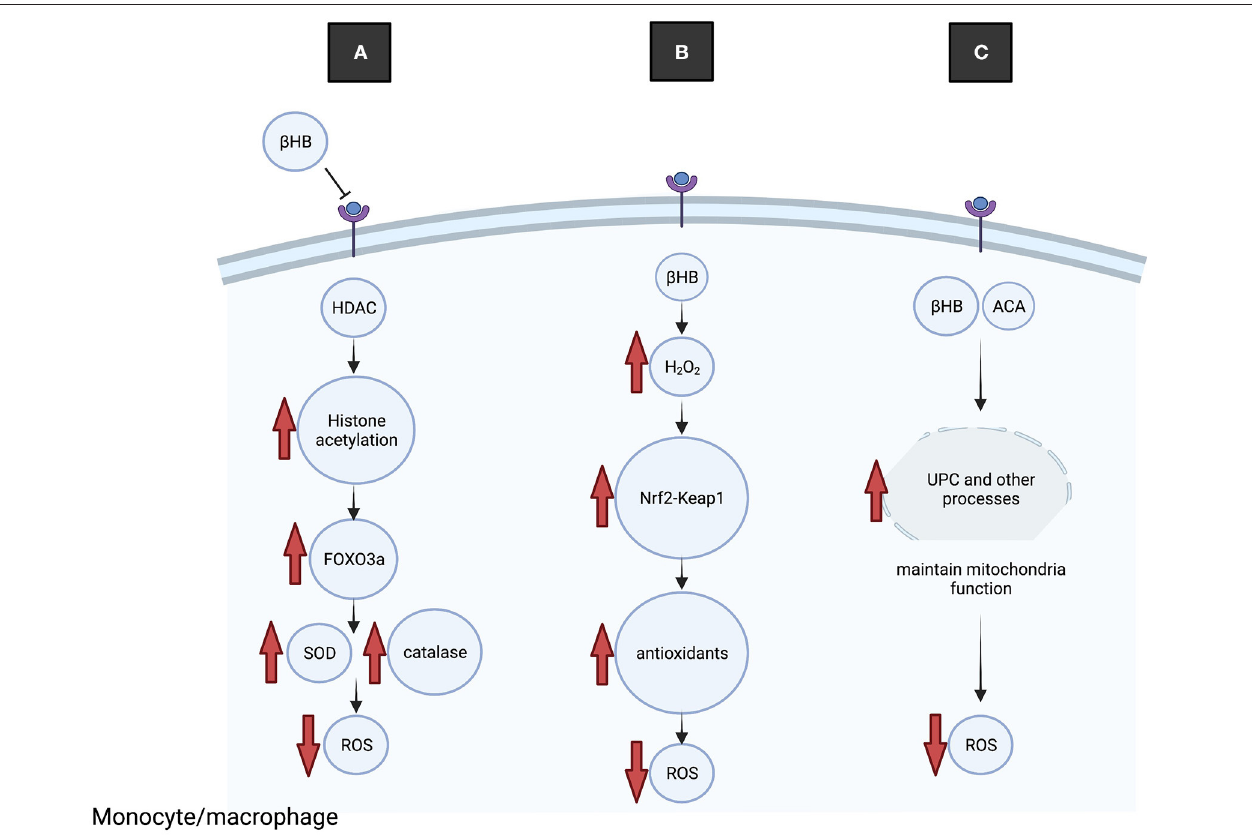
FIGURE 3 | The KD reduces oxidative stress. (A) BHB binds to and inhibits HDAC, leading to increased histone acetylation at the promotor of the transcription factor Foxo3a and increased expression. Foxo3a induces expression of antioxidant proteins SOD and catalase, leading to reduced ROS. (B) Transiently elevated H 2 O 2 leads to dissociation of Keap1 from Nrf2, nuclear translocation of Nrf2 and transcription of antioxidant genes, leading to reduced ROS. (C) Ketone bodies increase UCP activity, which improves mitochondrial functioning and reduces production of ROS.